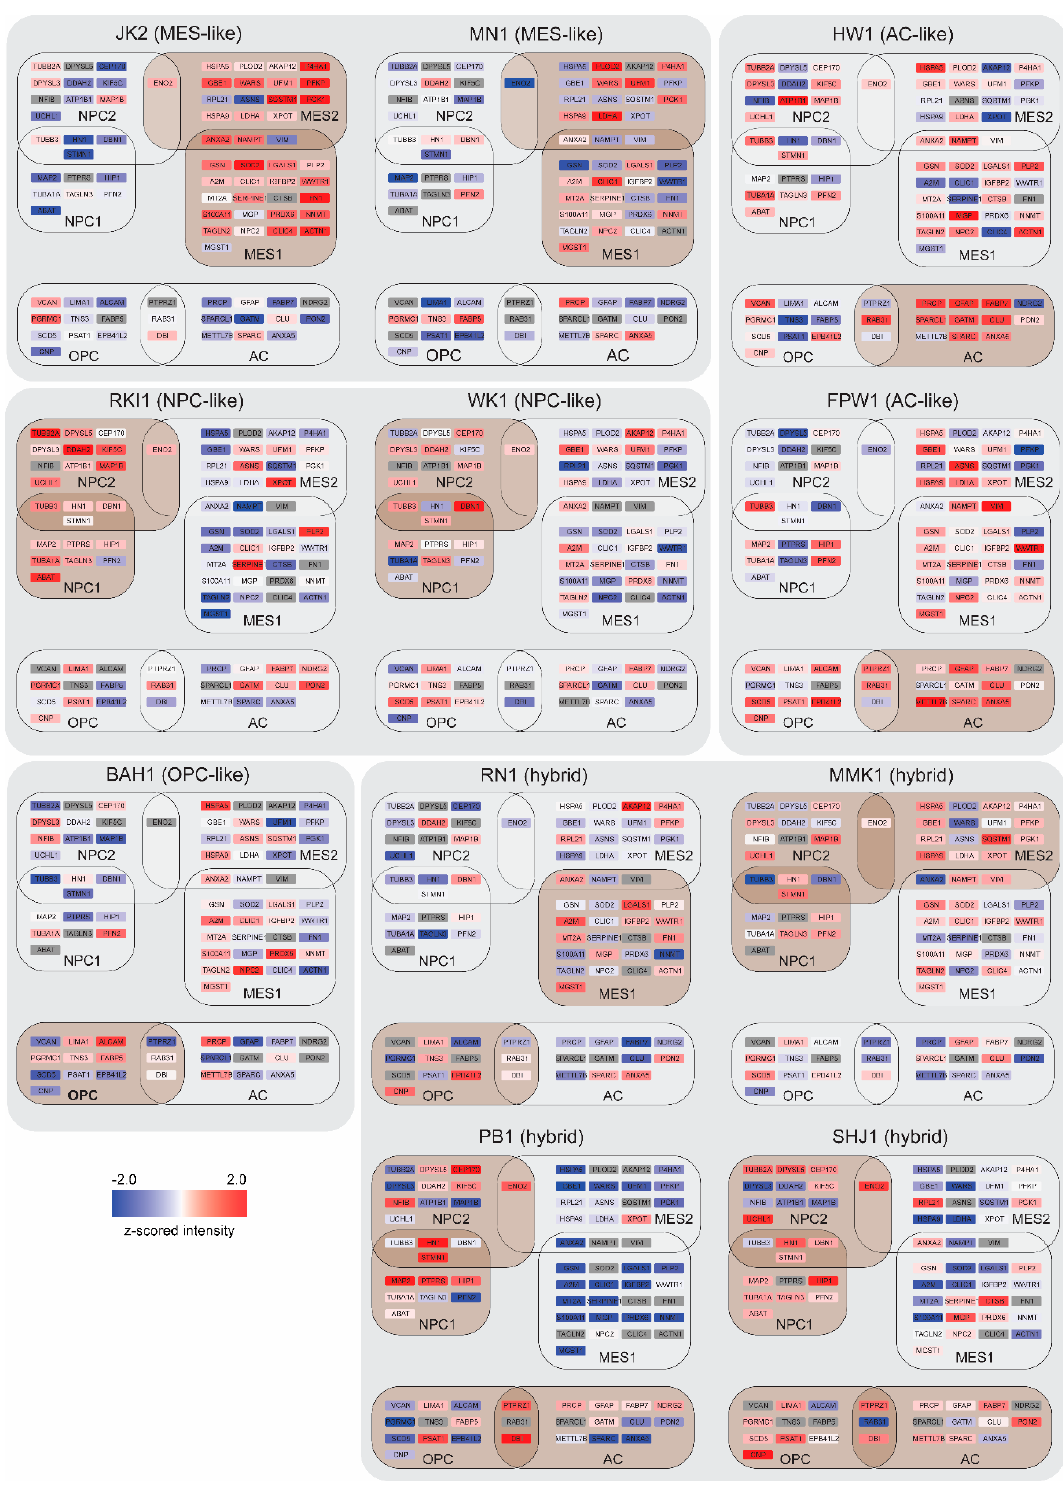
Figure 3. Depiction of cell-states in 11 GBM cell lines. z-scored expression values of genes that contribute to MES1-like, MES2-like, NPC1-like, NPC2-like, and AC-like metamodules (gene list from [9]). Brown boxes indicate predominant cell-state(s) in each cell line. Colour key: red, high expression; blue, low expression; grey, not detected.